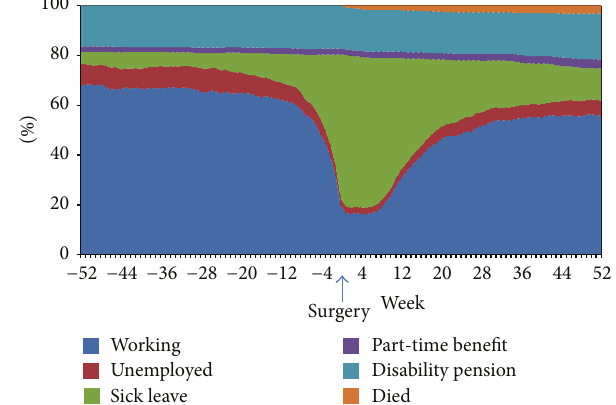
Figure 1: Work status for patients undergoing coronary artery bypass surgery and/or heart valve surgery in the North Denmark Region from one year before surgery to one year